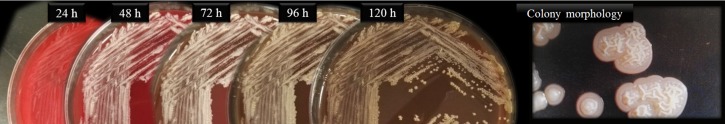
Evolution of colony appearance.